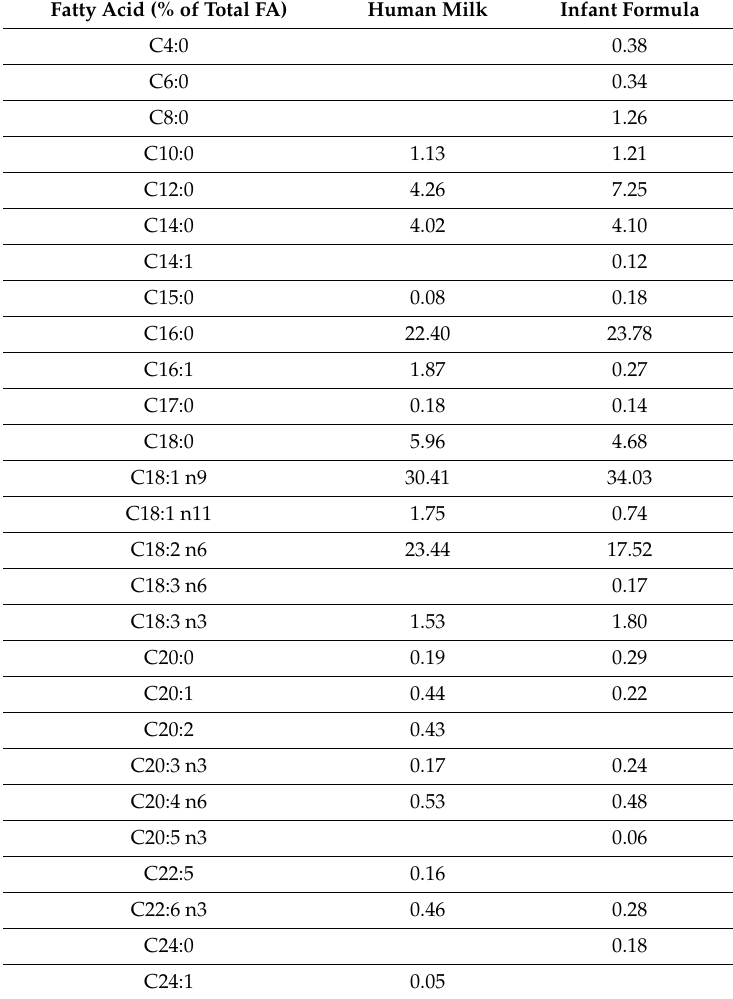
Figure 2. Boxplot of the overall brain sphingomyelin (SM) concentrations in negative ionization mode of rats fed human milk or infant formula. Mean separation by Fisher’s LSD (different upper case letters indicate significant difference at α = 0.05; n = 12). Table 1. Fatty acid profiles of human milk and infant formula